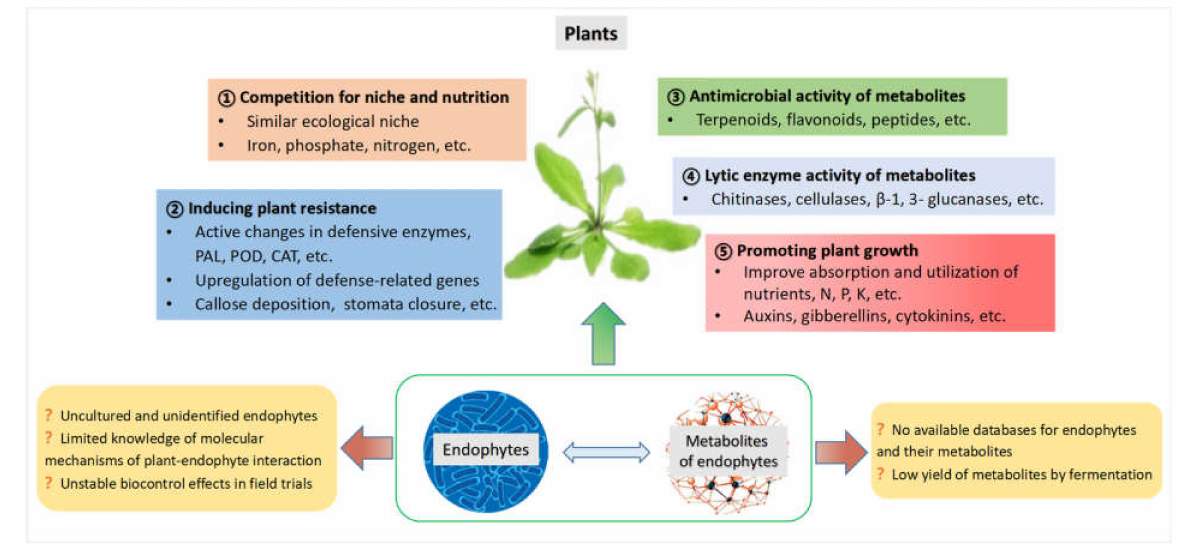
Figure 1. Multiple mechanisms employed by endophytes and their metabolites in plant disease